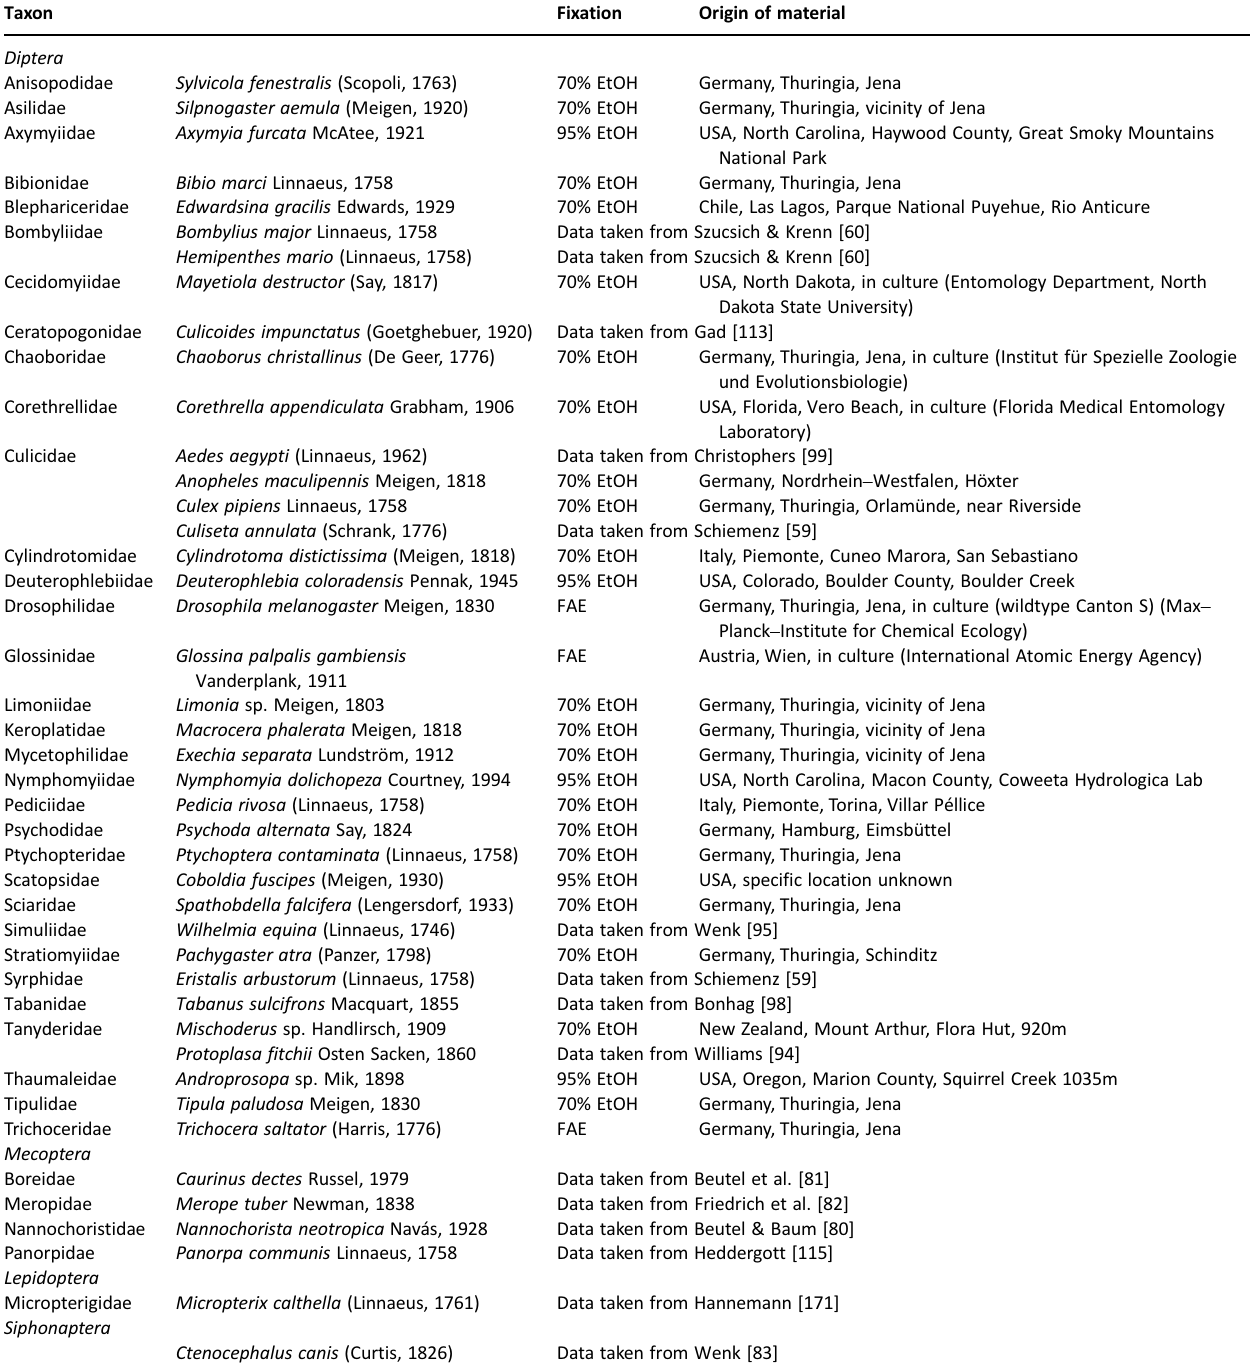
Table 1 . List of adult Taxa